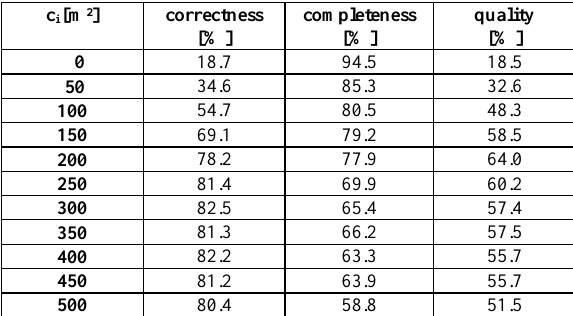
Table 1. Results for area 1 varying the weight c i in the data term.